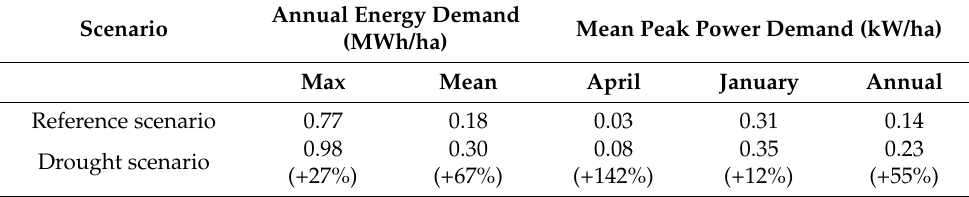
Table 8. The distribution of energy demand and peak power demand for irrigation water pumping across scenarios and time of the